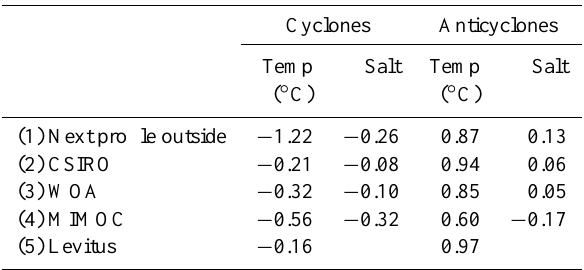
Table 3. Temperature and salinity anomalies of cyclones and anti- cyclones vertically averaged in the upper 350m. Anomaly profiles are calculated relative to different reference data sets: (1) the nearest in situ profile in time and space, (2) the CSIRO CARS2009a v1.1 climatology, (3) the monthly WOA09 climatology, (4) the monthly MIMOC v2.2 climatology, and (5) the monthly Levitus94 climatol- ogy (salt values are not included in monthly